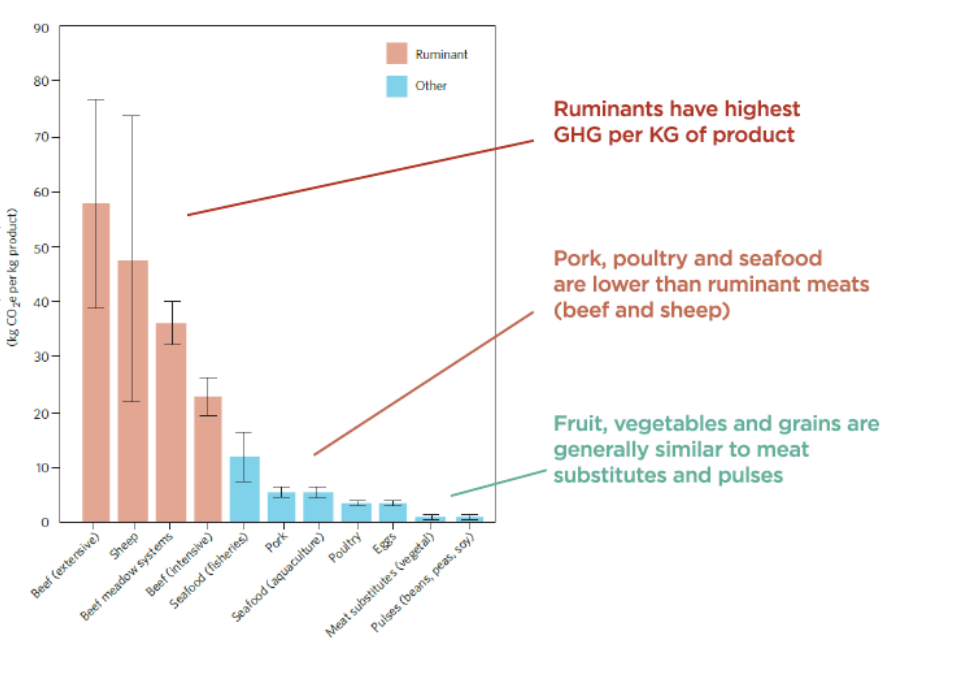
Figure 21: Average greenhouse gas emissions from different protein-rich foods per kg of product. Source: Ripple et al .